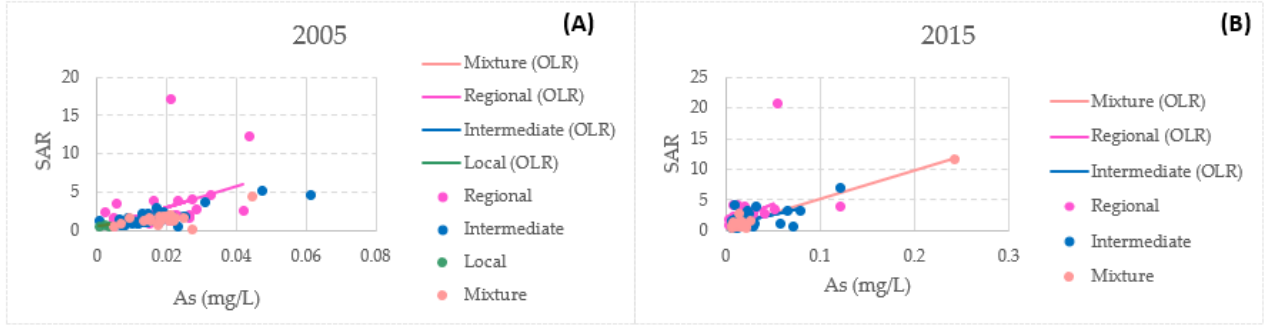
Figure 15. Uncertainty weighted least-squares linear regression (arsenic and SAR) for the different flow systems: ( A ) 2005 and ( B ) 2015.